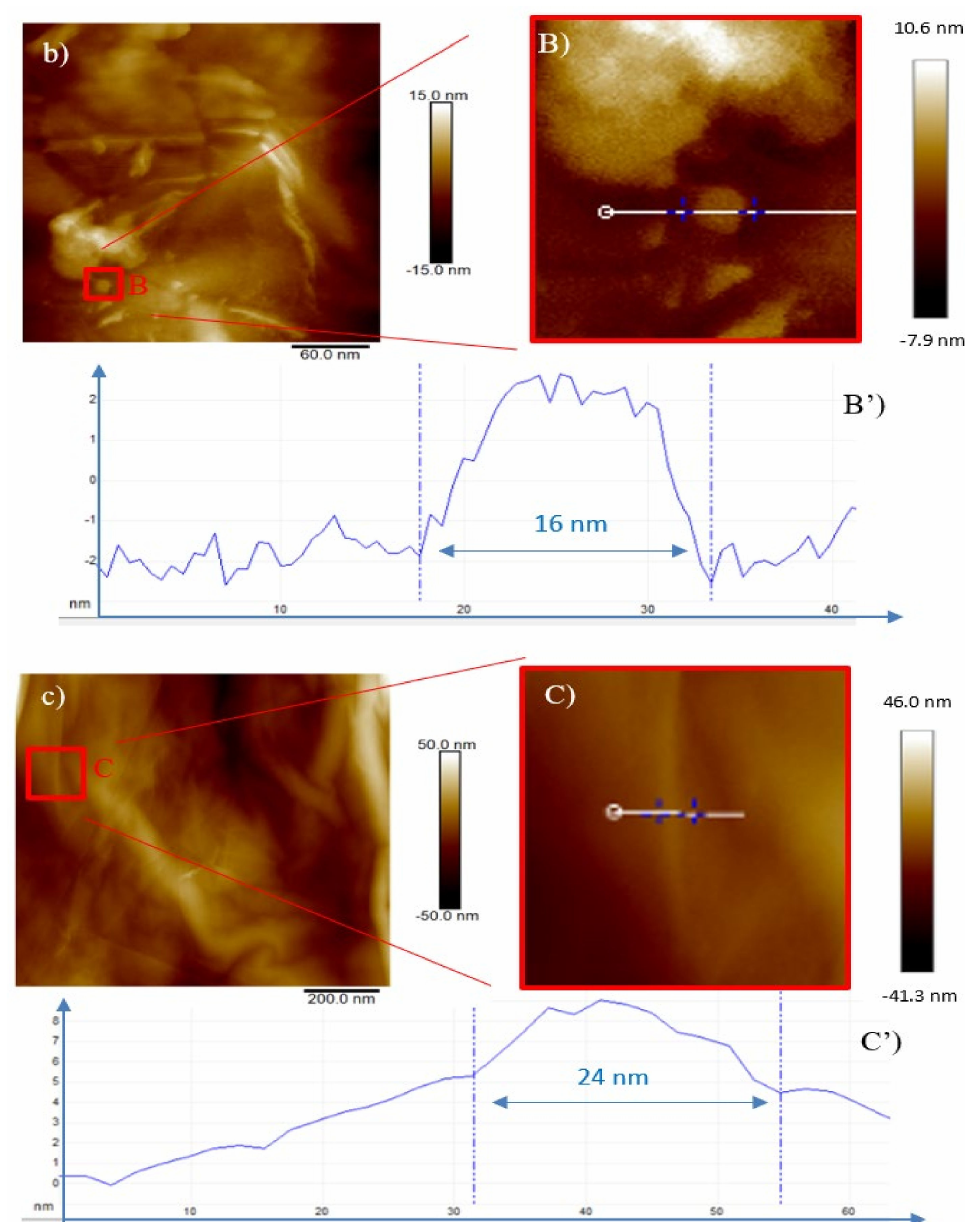
Figure 5. 2D AFM images of GO irradiated by the 3 MeV H + ions at the 5 × 10 11 ions/cm 2 ( a ), at the 5 × 10 12 ions/cm 2 ( b ) and at the 5 × 10 13 ions/cm 2 ( c ) fluences. Magnified areas of the red squares ( A – C ) and profiles of the corresponding selected structures ( A’ – C’ ),